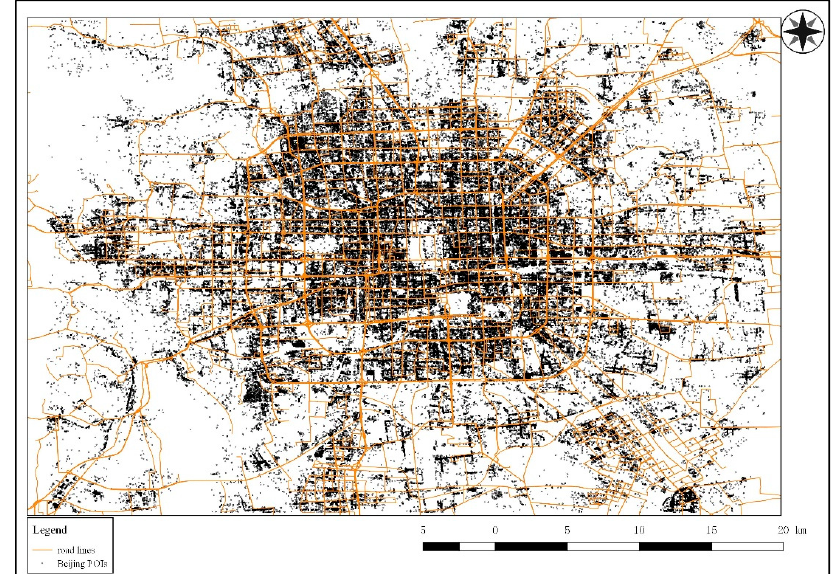
Figure 7. Research region. Yellow lines in the figure denote the main road data of Beijing and the small black dots indicate the POIs of Beijing.